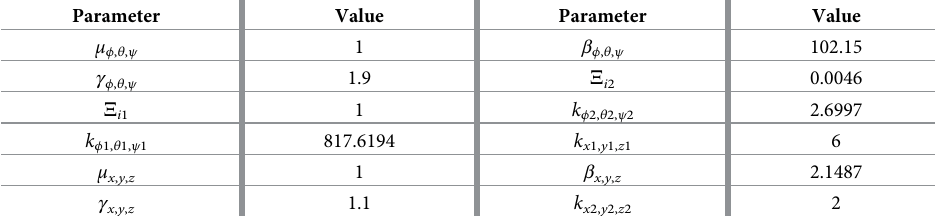
Table 2. Control system